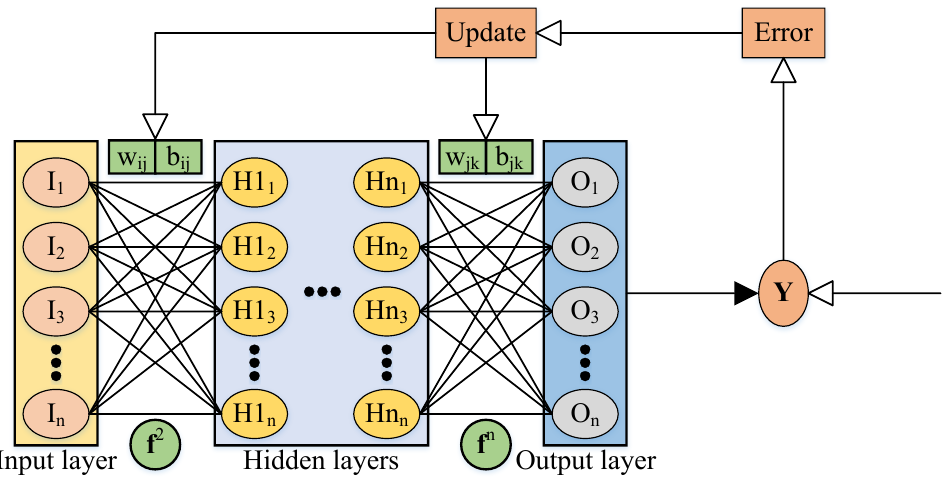
Figure 1. Deep neural network